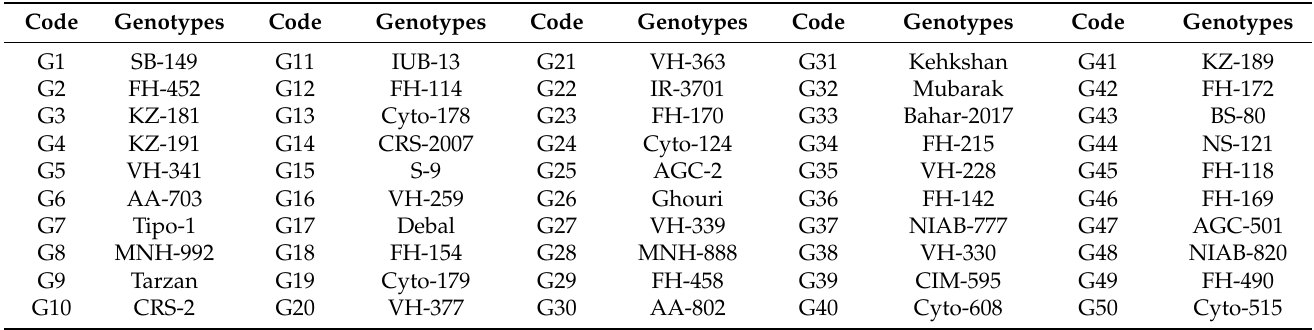
Table 1. List of cotton genotypes used to assess the potential in water deficit